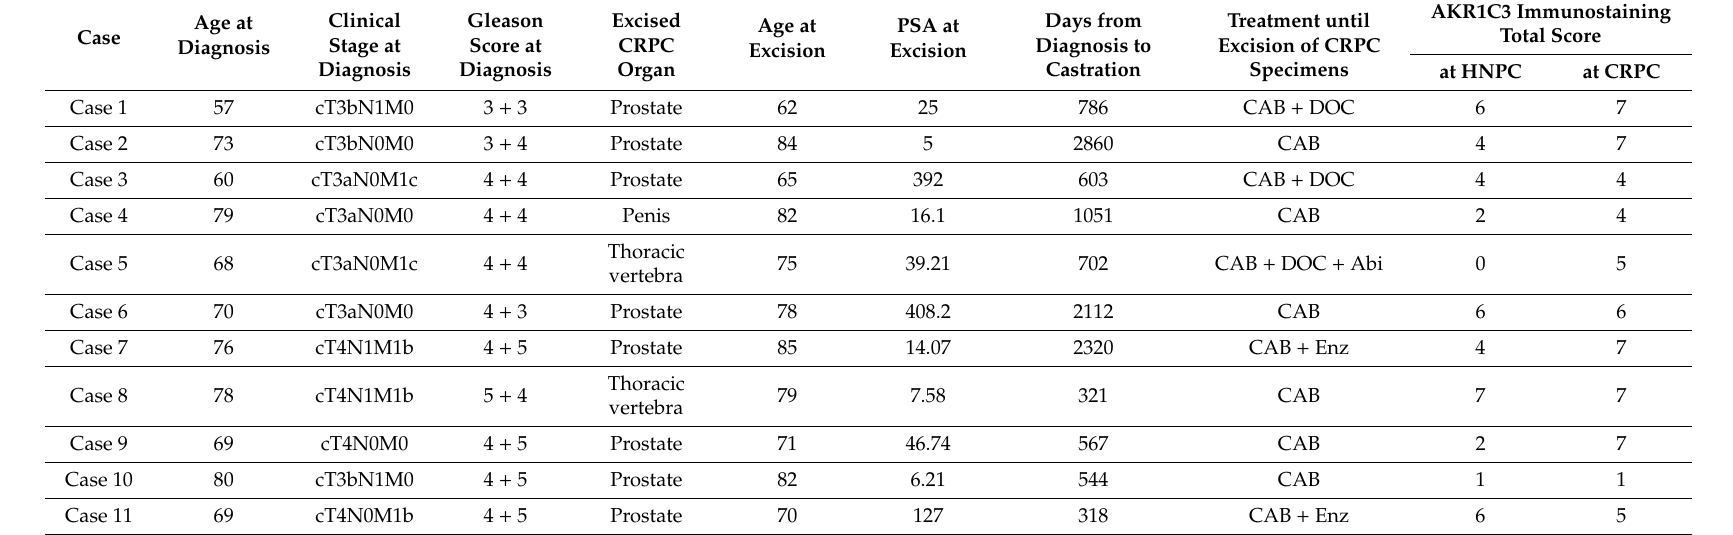
Table 4. Clinicopathological features and results of AKR1C3 immunostaining total score in 11 cases, including both hormone-naïve and castration-resistant